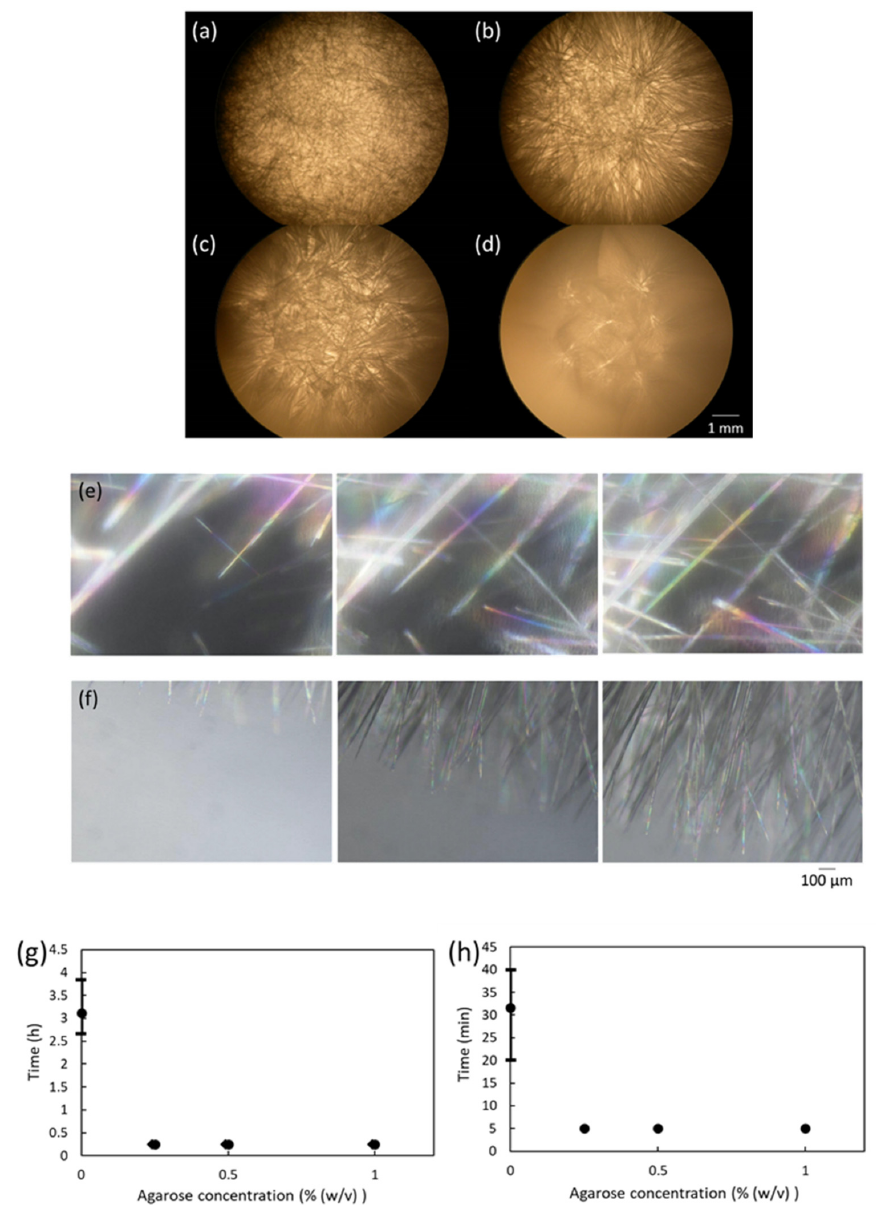
Figure 4. Growth and dissolution of trihydrate crystals in agarose gels. ( a – d ) After the growth. Agarose concentrations (% ( w / v )) of 0 ( a ), 0.25 ( b ), 0.5 ( c ) and 1.0 ( d ). ( e , f ) The growth process. Agarose concentrations (% ( w / v )) of 0 ( e ) and 0.25 ( f ). After 10 s (middle) and 20 s (right) from the left. ( g , h ) Relationship between agarose concentration and average dissolution time of trihydrate in 2.7 mL ( g ) and 0.35 mL ( h )